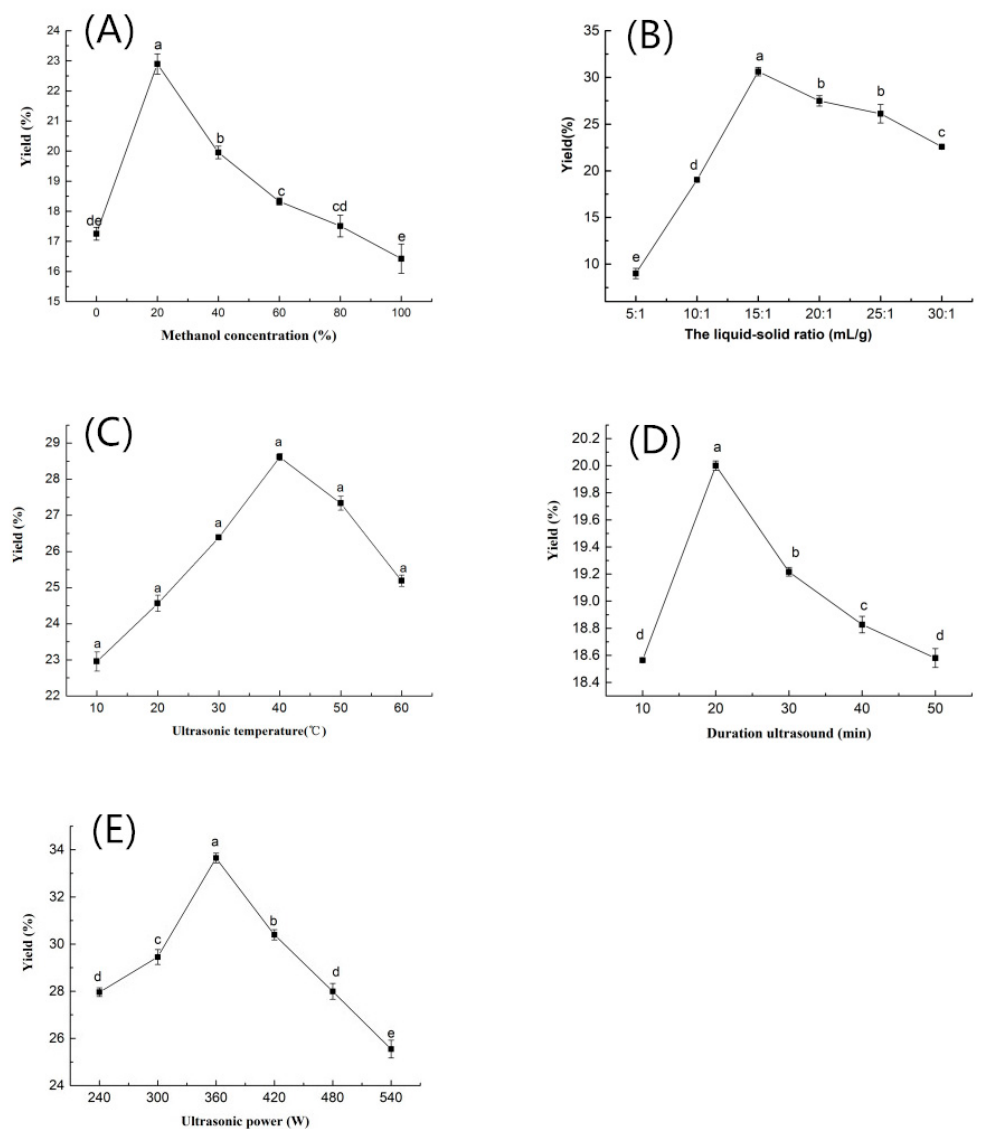
Figure 1. Effects of five factors on kinsenoside yield. ( A ) Effects of methanol concentration. ( B ) ( E ) E ff ects of ultrasonic power. Note: Di ff erent letters in the figures indicate significant di ff erence Effects of the liquid-solid ratio. ( C ) Effects of ultrasonic temperature. ( D ) Effects of the duration of ultrasound. ( E ) Effects of ultrasonic power. Note: Different letters in the figures indicate significant difference at 0.05 level.